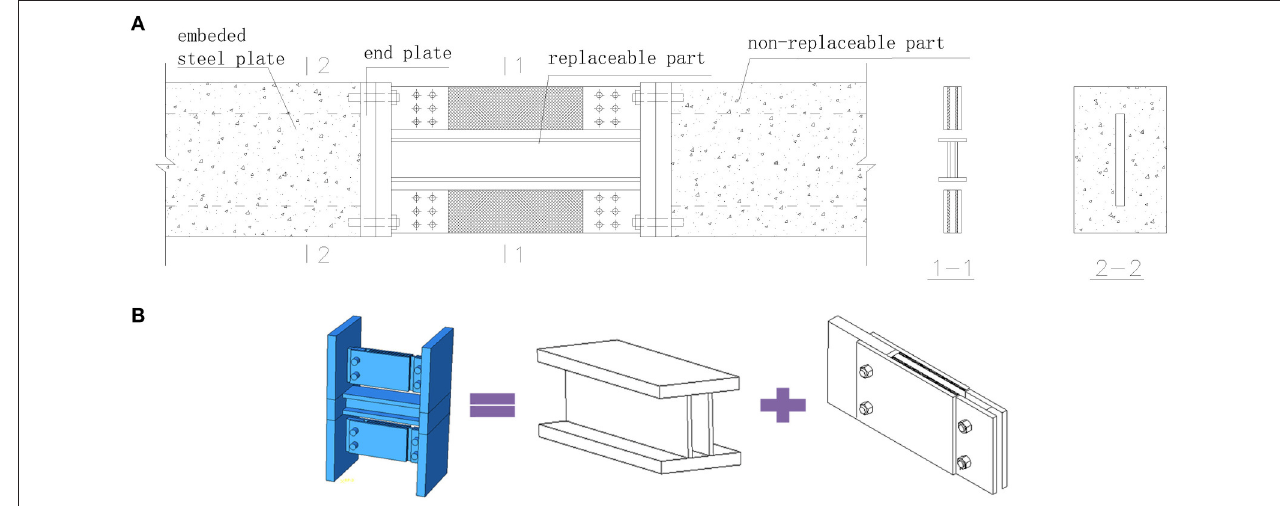
FIGURE 1 | Schematic drawing: (A) replaceable coupling beam; (B) the combined damper.